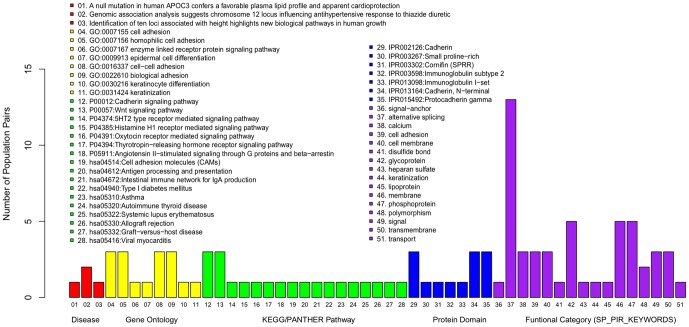
Functional categories among pairs of different population groups.Functional analysis was performed using DAVID annotation. The distribution of significant functional categories among the comparisons covered all the terms meeting a criterion of Benjamini FDR corrected p<0.05. Each color represents one functional term. The y-axis represents the frequency at which the functional term showing significant enrichment occurred in the comparisons of the nine groups in pairs.